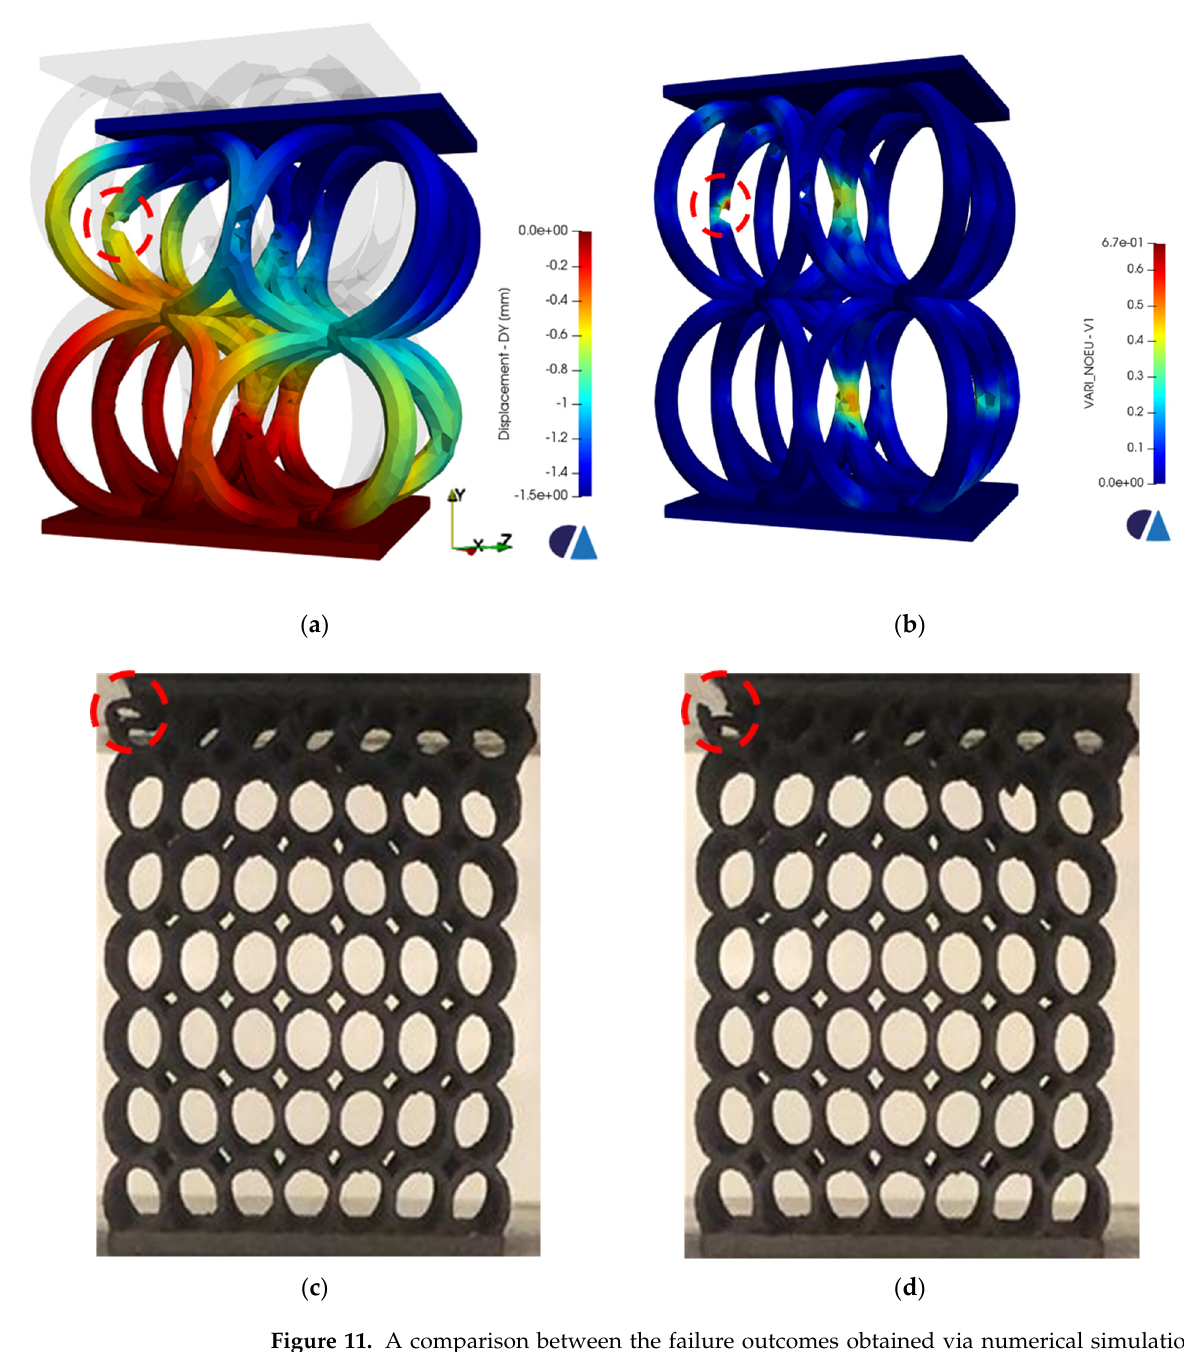
Figure 11. A comparison between the failure outcomes obtained via numerical simulation with the newly implemented algorithm and experimental ones. ( a ) and ( b ) show the displacement and the corresponding equivalent plastic strain acquired through 3D simulation, as well as the region where the fracture is initiated, which is marked by a red circle. ( c ) and ( d ) are images taken from previous experiments [41] for the same, but bigger lattice structure with the region of initial and complete fracture also marked by the red circle, respectively.